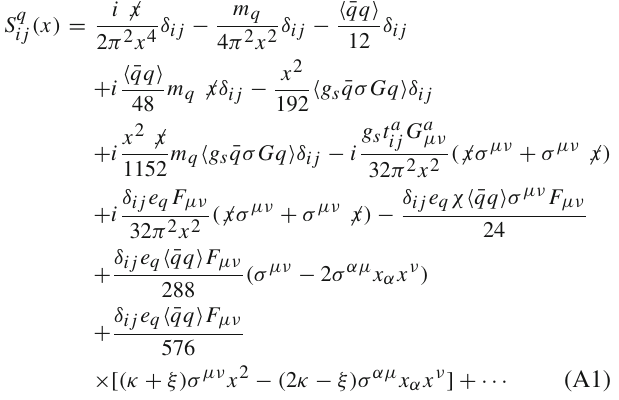
on M 2 at three different values of s P c B c depends c